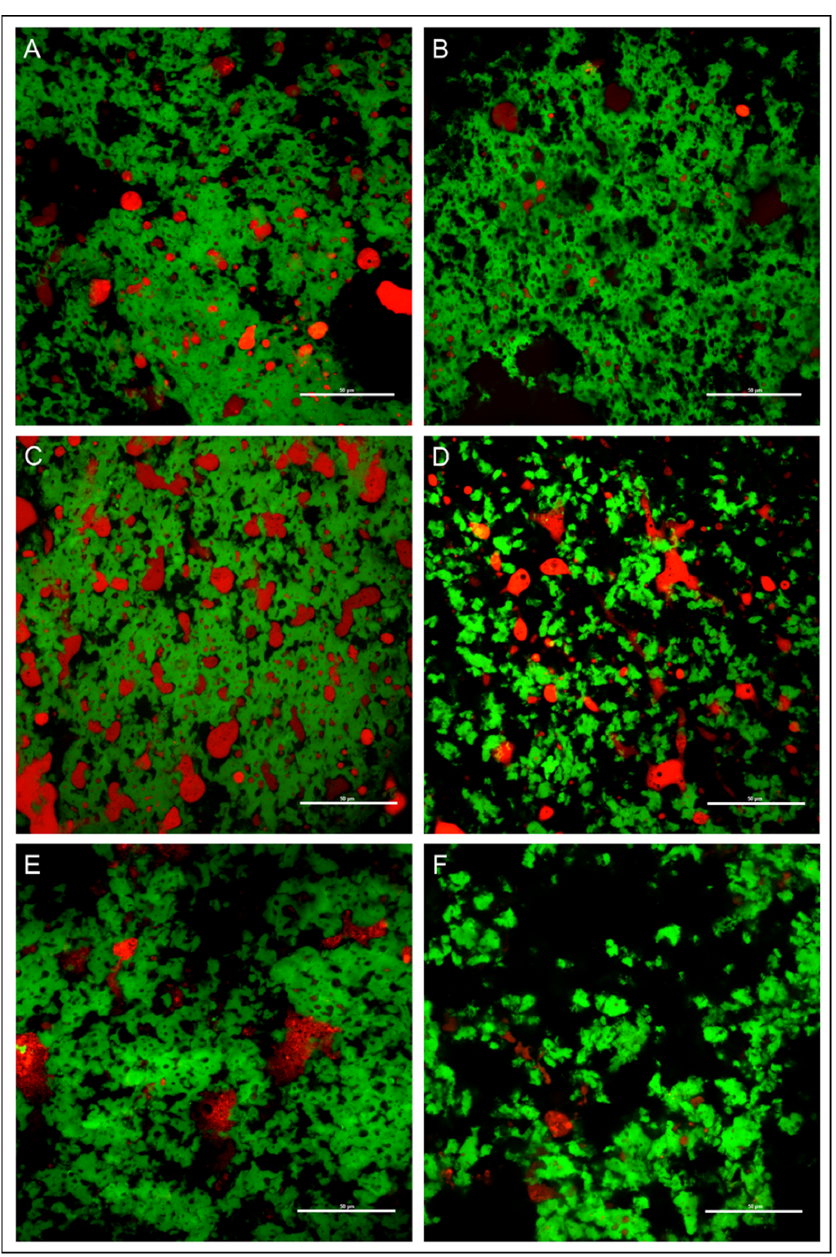
Figure 3. Microstructure of cheese. ( A , C , E ) Confocal microscopy image of cheese from Teramana goat milk; ( B , D , F ) cheese from Saanen goat milk. Samples were ripened for 0, 30, 60 days. The Nile Red stained fat appears red and the fast green FCF stained protein appears green in these images. Table 5. Physical properties of cheese at 0 (T0), 30 (T30), and 60 (T60) days of ripening, obtained from the milk of goat breeds: Teramana and